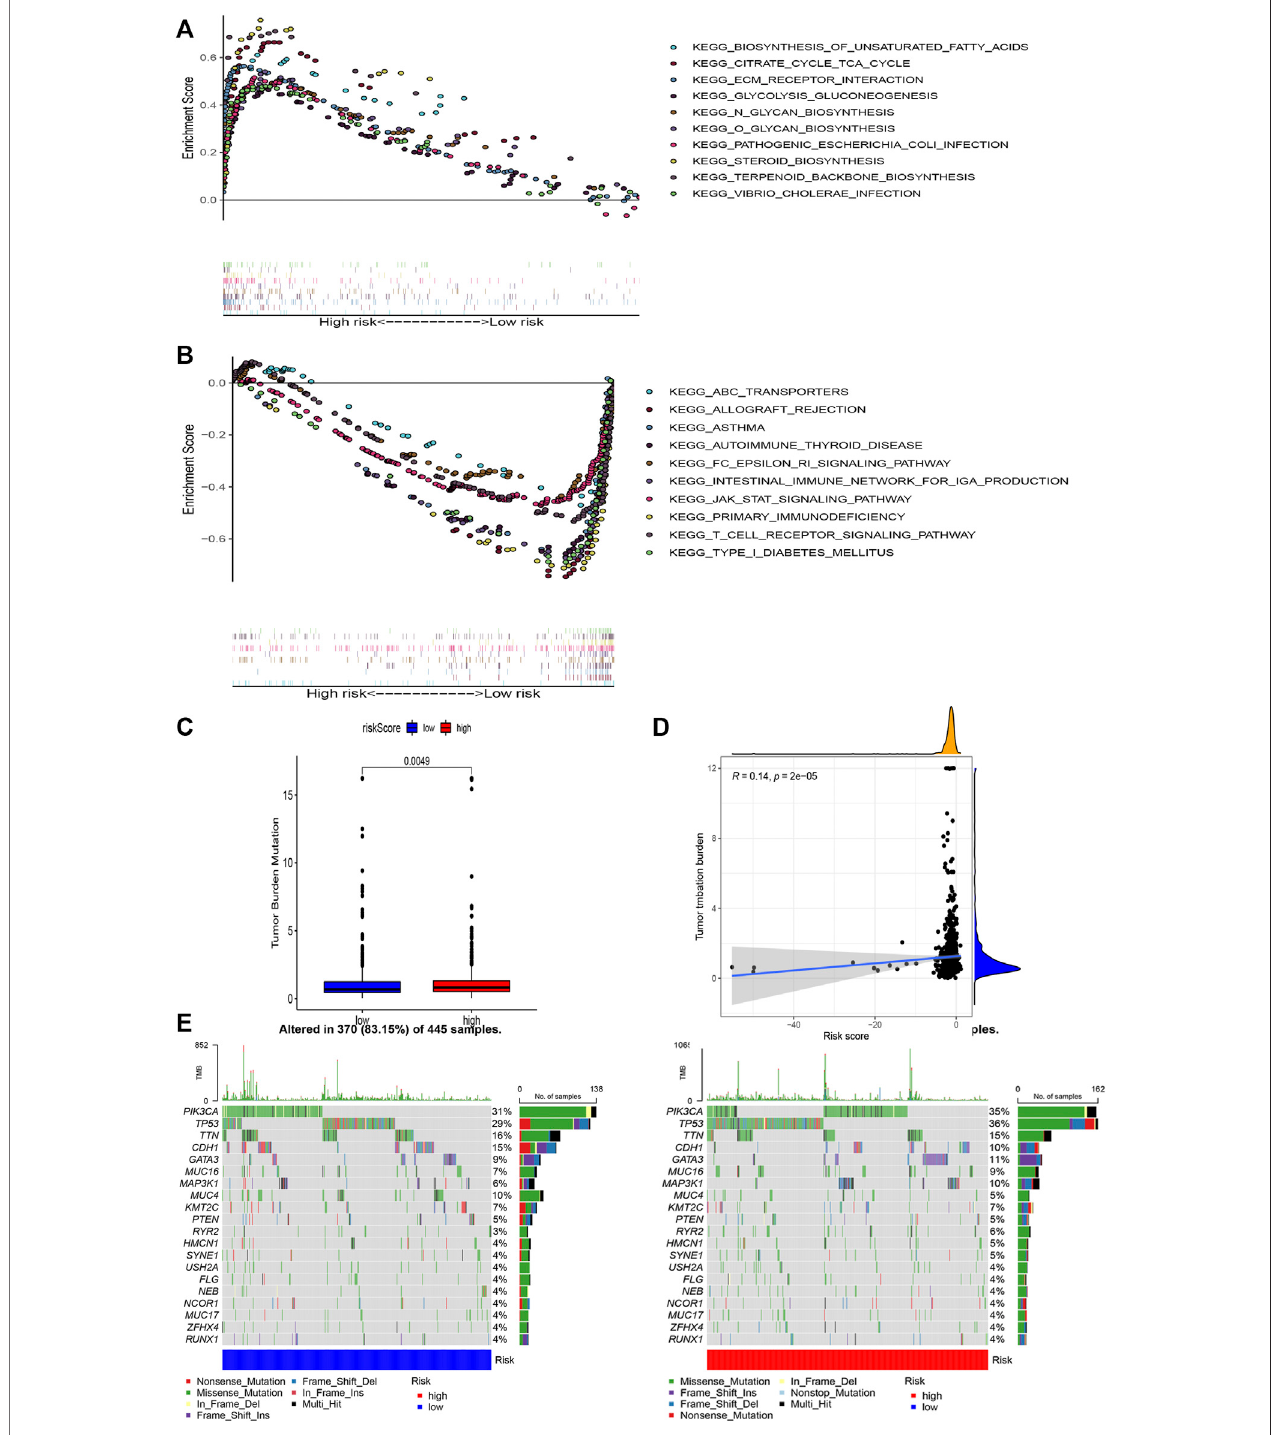
FIGURE 6 | Gene enrichment analysis for AAM-related lncRNAs based on TCGA in the high (A) and low (B) BRCA risk groups. Correlation between the TMB and the two risk subsets (C) . Association between the TMB and risk score (D) . Prominently mutated genes in the patients with BRCA in the different risk subgroups. The mutated genes (rows, top 20) are ranked according to mutation rate; samples (columns) are arranged to emphasize the mutual exclusivity among mutations. The right panels depicts the mutation percentage, and the top panel indicates the overall number of mutations. The color coding indicates the mutation type (E) .